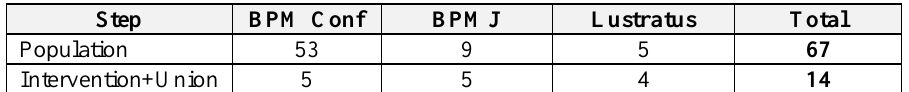
Table 1. Numbers of selected papers in SLA